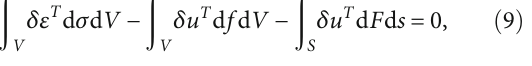
Figure 1: Single-phase solution validation